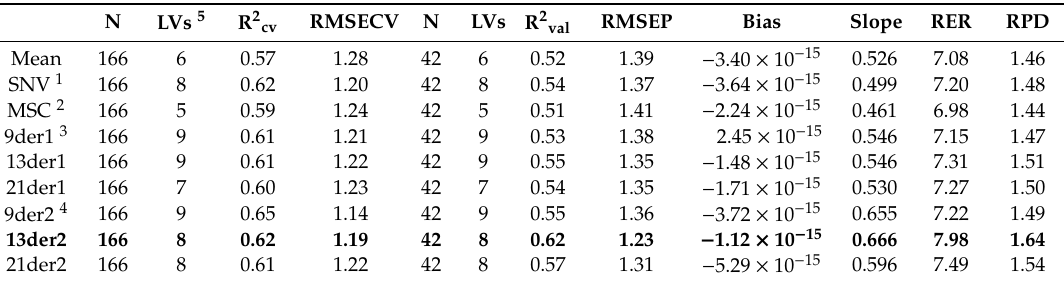
Table 3. Summary of the PLS regression models developed for the prediction of ash content on air-dried ground woodchip material (WD gr ). The best model is highlighted in bold. The vertical line in bold is used to divide calibration (on the left) and validation (on the right)